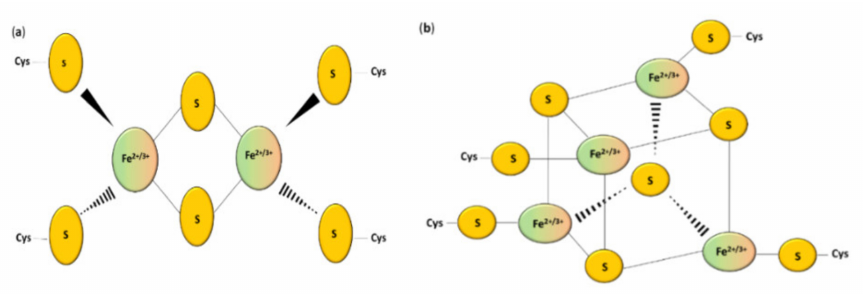
Figure 1. Structure of the most common Fe–S clusters: ( a ) [2Fe–2S]; ( b ) [4Fe–4S] clusters